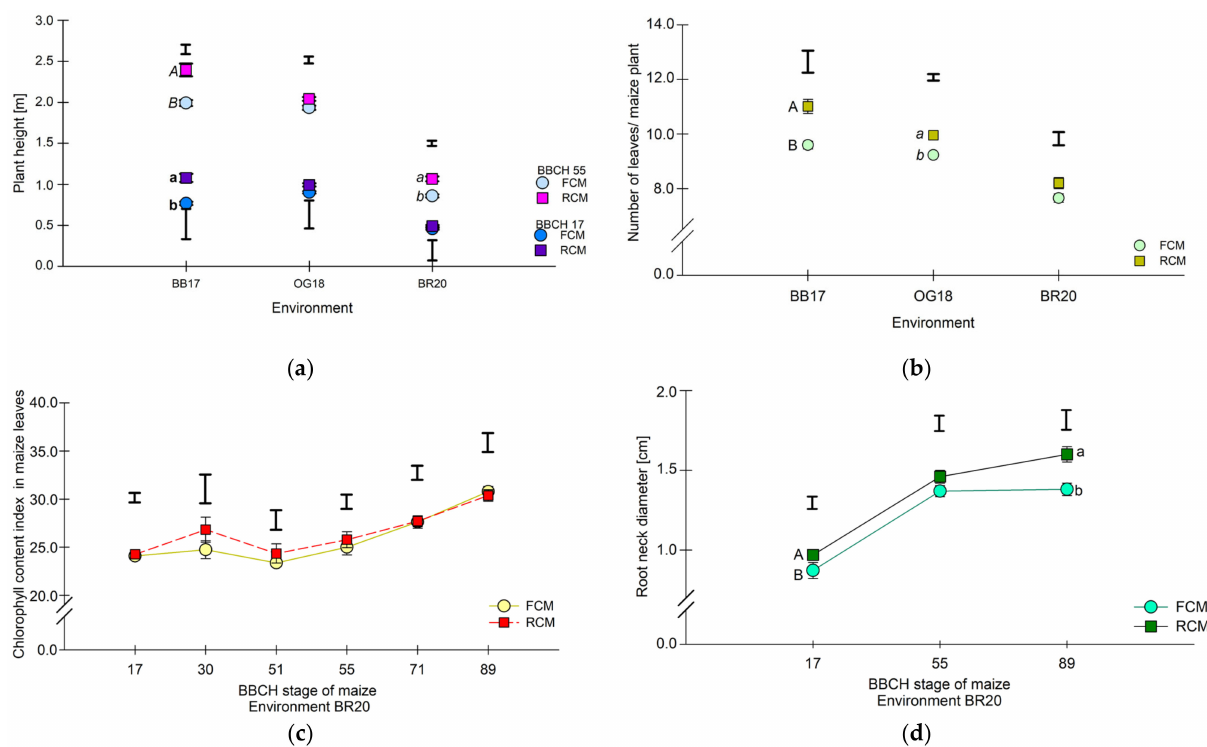
Figure 5. Plant development parameters of maize in flat cultivation method (FCM) and ridge cultiva- tion method (RCM). ( a ) Plant height in Environments (Ens) Bösenbrunn 2017 (BR17), Oberhermsgrün 2018 (OG18) and Bergen 2020 (BR20) during BBCH 17 (7 leaves unfolded) and 55 (middle of tassel emergence: tassel begins to separate). ( b ) Number of leaves per plant in Ens BR17, OG18 and BR20. ( c ) Chlorophyll content index in maize leaves over BBCH stages 17 (7 leaves unfolded), 30 (begin- ning of stem elongation), 51 (beginning of tassel emergence), 55 (middle of tassel emergence: tassel begins to separate), 71 (beginning of grain development, about 16% dry matter) and 89 (fully ripe) in En BR20. ( d ) Root neck diameter over BBH stages 17, 55 and 89 in En BR20. ( a – d )—arithmetic means ± standard error. Single-factor analysis of variance with subsequent Tukey–Kramer. Different letters (A, B and a, b) indicate significance at p < 0.05 between FCM and RCM at the respective BBCH stage or Environment. Bold error bars ( a – d ) indicate how large an observed difference must be to call it significant: honestly significant difference (HSD) for the respective data